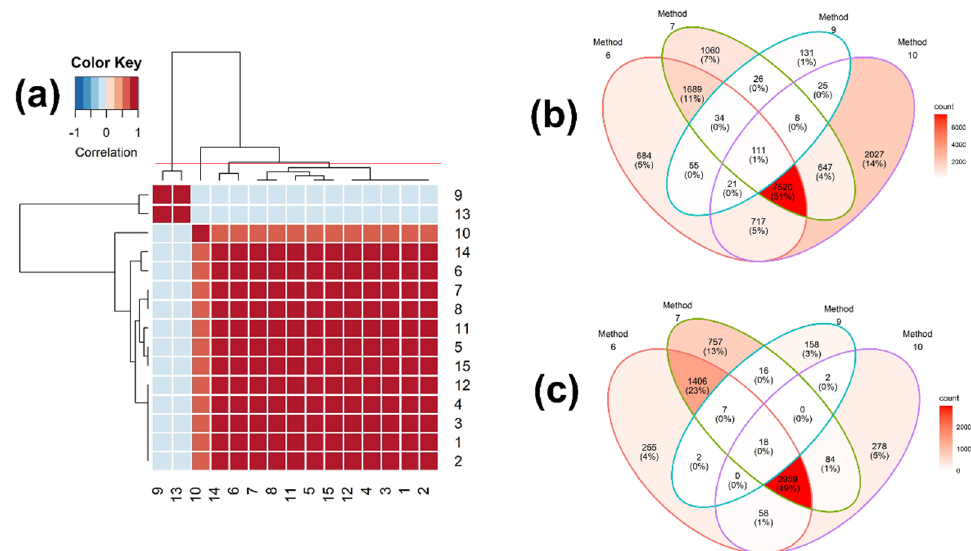
Figure 3. ( a ) Heatmap of the correlation matrix of the identification results among 15 binary similarity measures for Rank 1 and ( b , c ) Venn diagrams of consensus analysis among 4 selected binary similarity measures for EI mass spectra-based compound identification. In ( a ), the correlation was calculated using Pearson’s correlation coefficients. The horizontal red solid line indicates the four clusters generated by hierarchical clustering. The numbers in row and column represent the indices of binary similarity measures corresponding to Table 4 of Section 4. In ( b ), the Venn diagram was constructed based on all reference compounds with the highest corresponding similarity scores. In ( c ), the Venn diagram was constructed based on all reference compounds that were corrected identified.